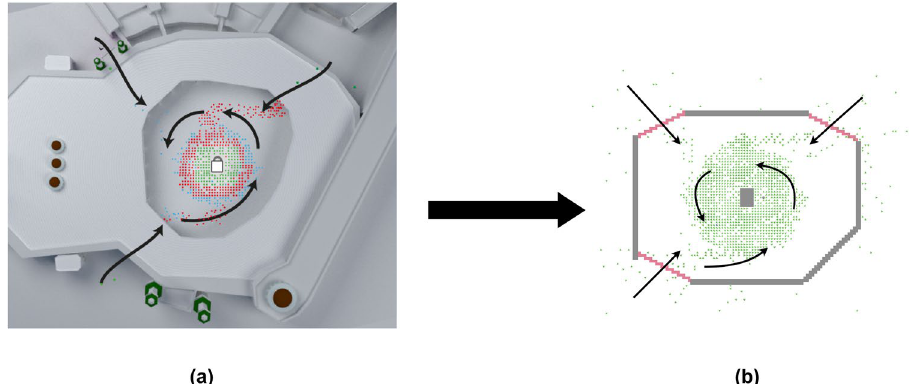
Figure 1. The environment is represented as a grid. The colored dots are simulation indicators representing the agents. ( a ) Overlays the environment model with the geometric blueprint of the Mataf area to highlight the captured spatial structure. ( b ) shows the environment model and crowd dynamics in NetLogo. The overall crowd dynamics are shown using the arrows: agents initially begin outside the Mataf area and aim to move towards the center in a counterclockwise spiral pattern within the spatial constraints of the area.